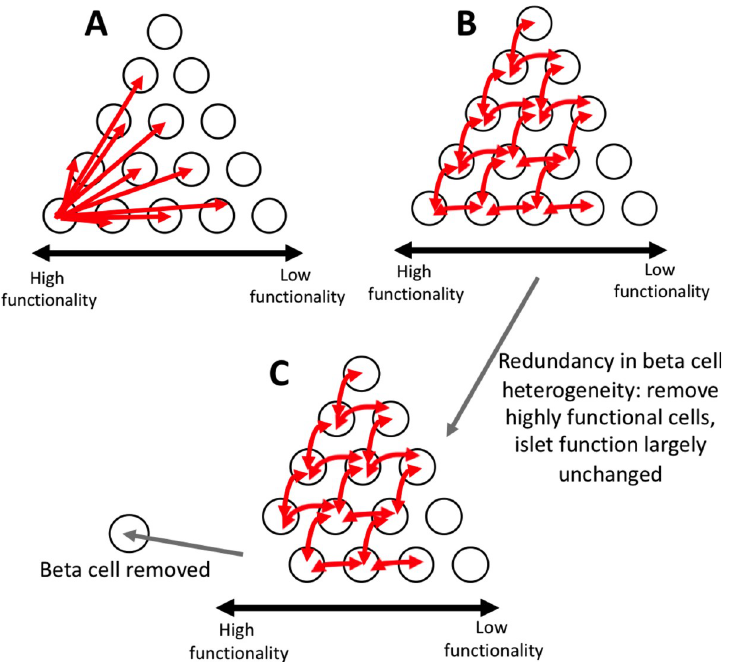
Fig 8. Schematic of multicellular dynamics of the islet. A). Schematic of suggestion that small subpopulations of highly functional cells can control whole islet dynamics. White circles represent β -cells. Red arrows represent which cells can be controlled by individual cell where the arrow begins. Increasing functionality in cells is from right to left B). Same as A, but a schematic of how our simulations predict islet [Ca 2+ ] dynamics are controlled. Our simulations predict that control is redundant, and many cells can control many other cells. Our simulations predict there is not one small subpopulation that controls the entire islet. C). Same as B, but schematic of how our simulations predict the islet responds when highly functional subpopulations are removed. When highly functional subpopulations are removed, the remaining cells are able to maintain the function of the islet due to the redundancy in